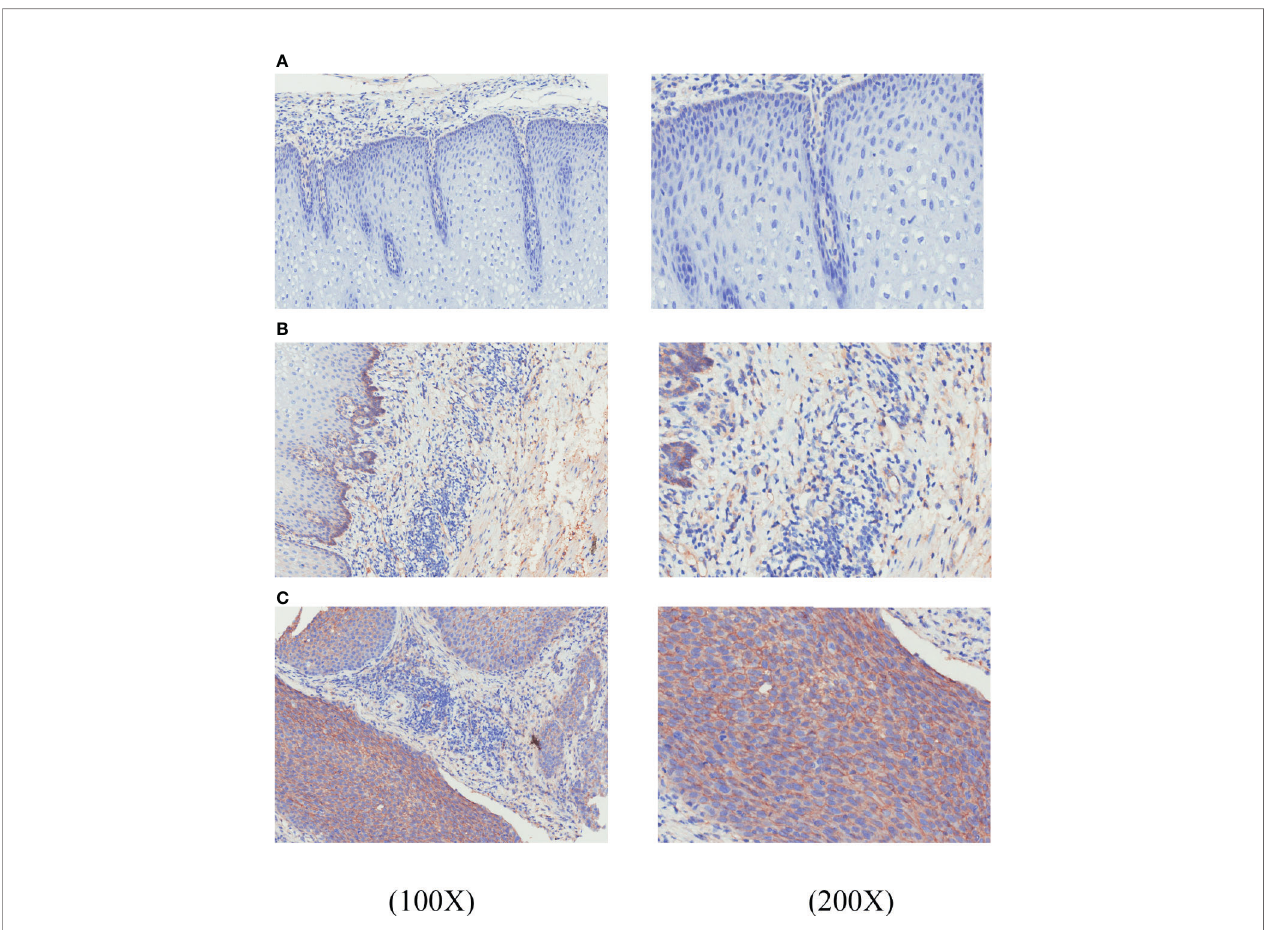
FIGURE 7 | GNA11 is overexpressed in ESCC tissues compared with corresponding para-tumor tissues by immunohistochemistry. The histopathology of these tissue samples was tested by hematoxylin and eosin (H&E) staining. (A) A representative negative expression of GNA11 protein in para-tumor tissues at ×100 and ×200 magni fi cation. (B) Weak positive expression of GNA11 protein in representative para-tumor tissues at ×100 and ×200 magni fi cation. (C) Positive expression of GNA11 protein in representative ESCC tissues at ×100 and ×200 magni fi cation. ESCC, esophageal squamous cell